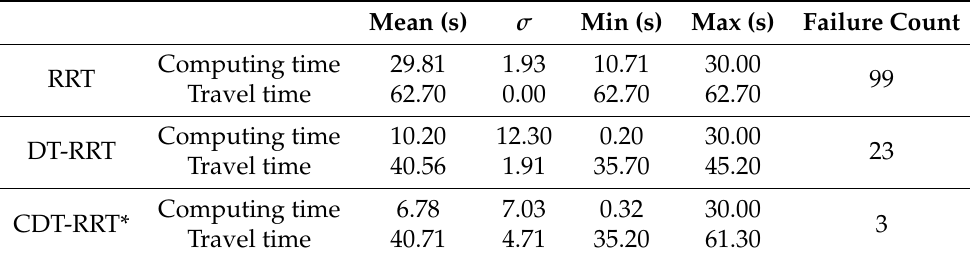
Figure 10. Histogram of the computing time for the results from simulation 4. Table 5. Summary of Planning Results from simulation 4.